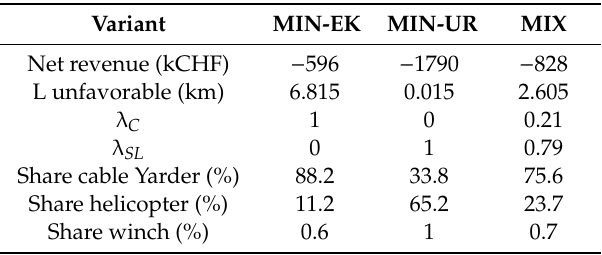
Table 8. Characteristic values of the CR layouts calculated with di ff erent weights λ C and λ SL . “L unfavorable” quantifies the CR length in the unfavorable